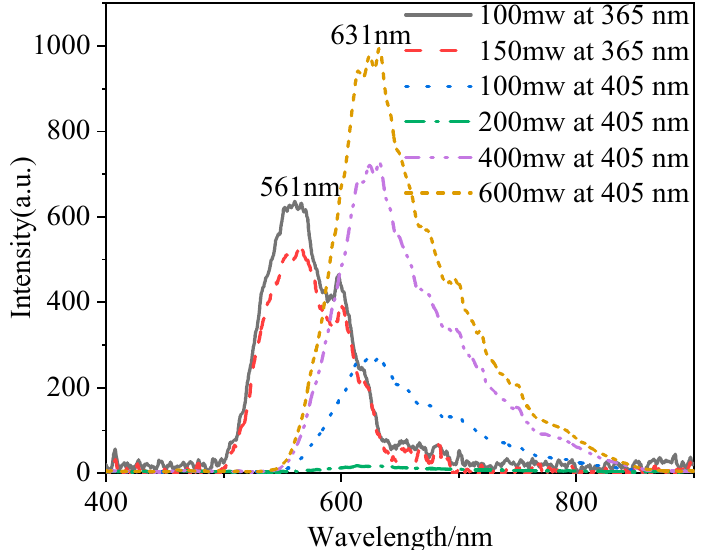
Figure 8. Emission spectra of Yb 2+ -doped fiber with a length of 30 cm as a function of pump power with excitations of 365 and 405 nm.